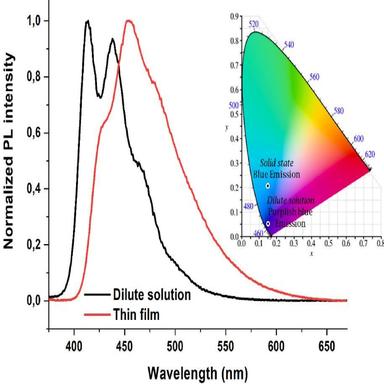
PL spectra of M-DSB; in chloroform dilute solution (2.10− 5 M) and in thin film (80 nm); inset: The CIE chromaticity diagram of the M-DSB.